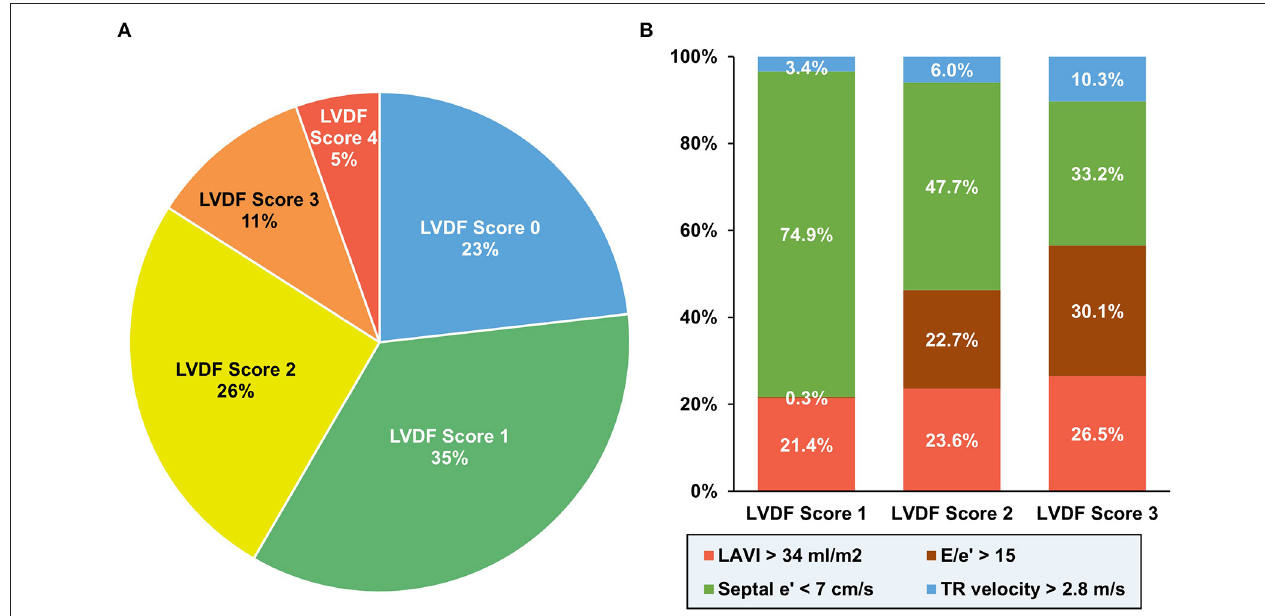
FIGURE 1 | Distribution of diastolic function according to LVDF score. An LVDF score of 1 was the most prominent (35%) (A) , while an abnormal septal e’ was the most common feature (B) . LAVI, left atrial volume index; LVDF, left ventricular diastolic function; TR, tricuspid regurgitation.